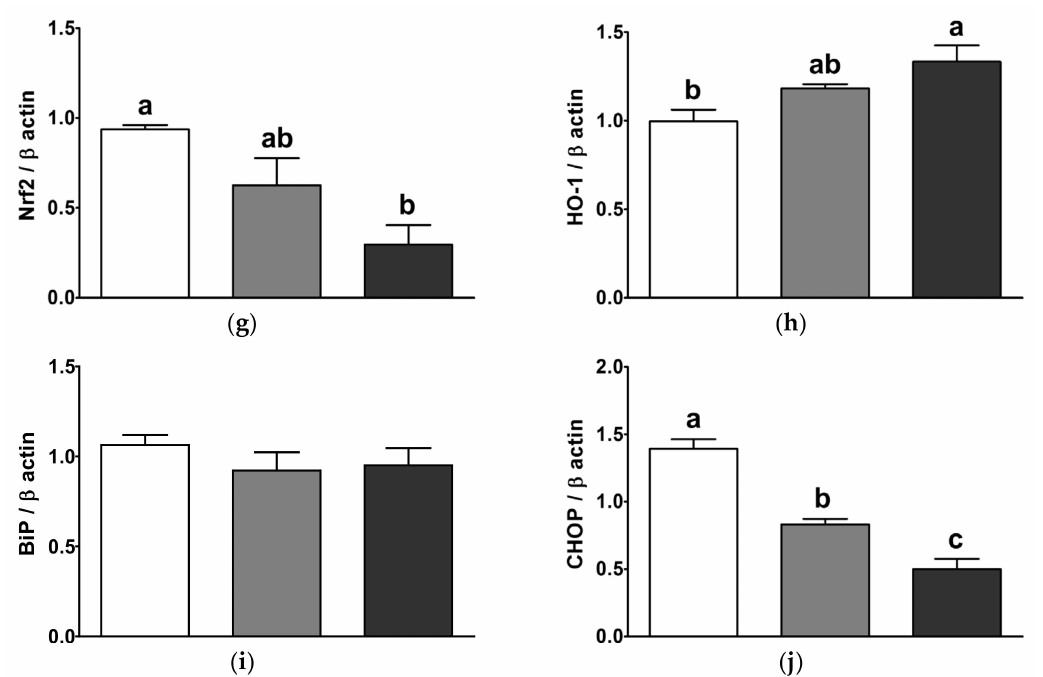
Figure 9. Effects of partial replacement of dietary fat with PO or CO and LPS stimulation on the levels of proteins related to the nuclear factor-kappa B (NF-kB) and mitogen-activated protein kinase (MAPK) pathways, oxidative stress, and ER stress in the liver. Five-week-old male Sprague-Dawley rats were fed either the HFD, HFD + PO, or HFD + CO for 12 weeks and then treated with LPS (5 mg/kg) for 24 h ( n = 8 per group). ( a ) Representative Western blot images; ( b ) phospho- nuclear factor of kappa light polypeptide gene enhancer in B-cells inhibitor alpha (p-IkB α ) level; ( c ) phospho-nuclear factor kappa-light-chain-enhancer of activated B cells (p-NF- κ B) level; ( d ) phospho-c-Jun N-terminal kinases (p-JNK) level; ( e ) phospho-extracellular signal-regulated kinases (p-ERK) level; ( f ) phospho-p38 (p-p38) level; ( g ) nuclear factor erythroid 2-related factor 2 (Nrf2) level; ( h ) heme oxygenase 1 (HO-1); ( i ) binding immunoglobulin protein (BiP) level; ( j ) C/EBP homologous protein (CHOP) level. The expression of each protein was normalized to a value for β -actin, the internal control of protein content. Values are presented as the mean ± standard deviation. Data were analyzed using one-way ANOVA and Tukey’s multiple comparisons post hoc test for multiple comparisons. Means with different letters indicate significant differences at p < 0.05. LPS,